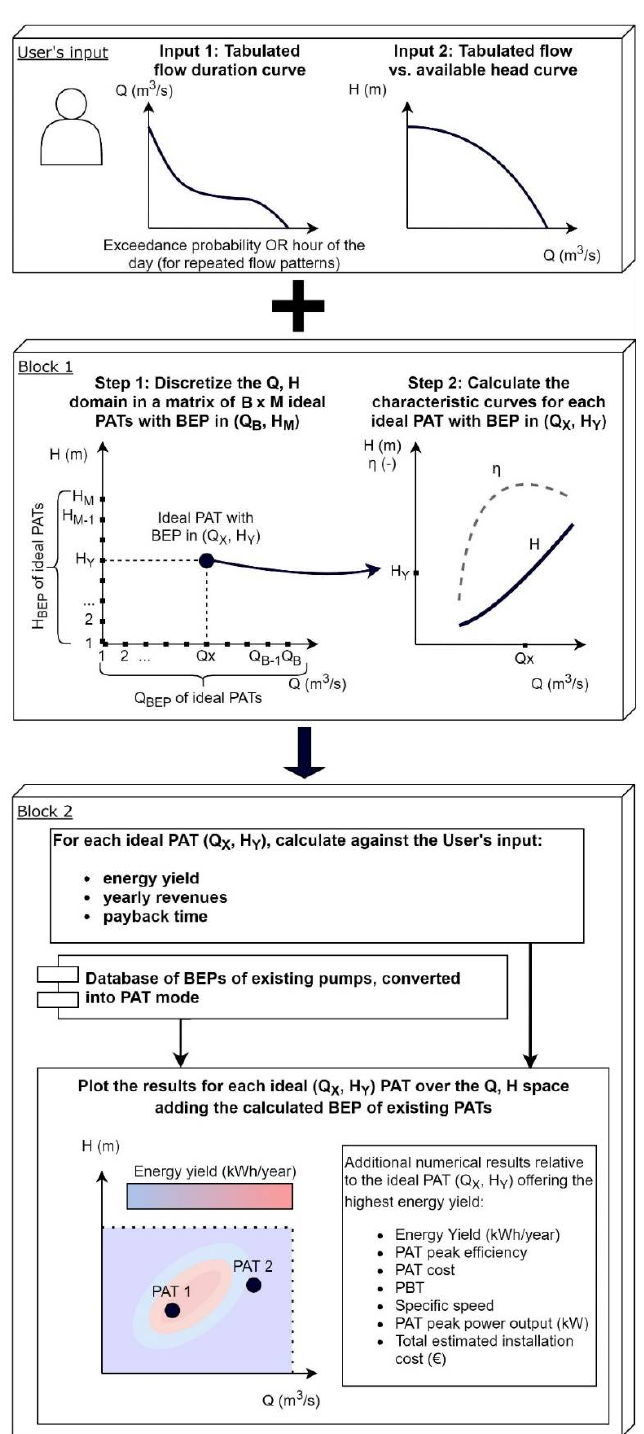
Figure 1. Schematic layout of the software logic.